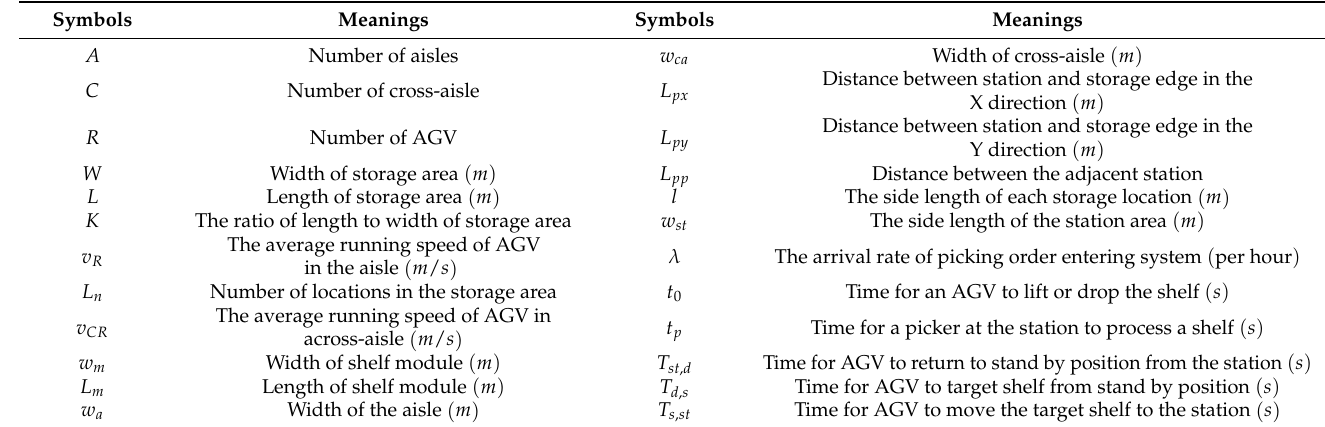
Table 1. Main system parameters and their